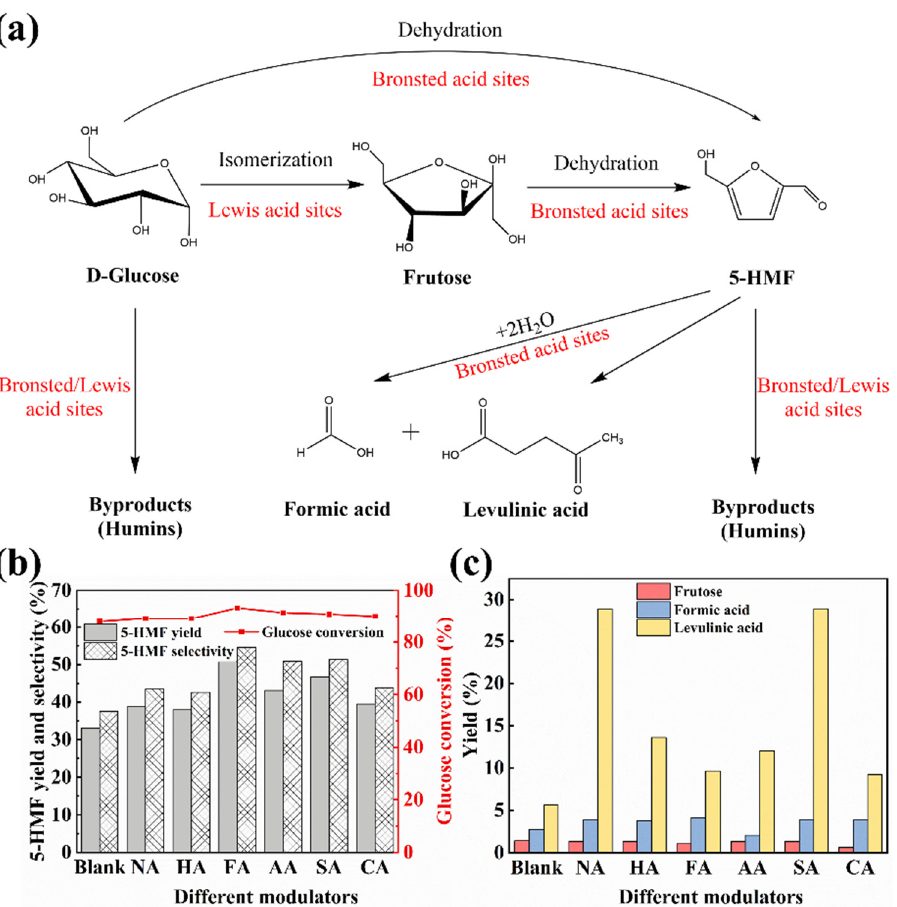
Figure 8. Effects of the blank sample and MIL-101 (Cr, Sn) synthesized with different modulators on glucose conversion to 5-HMF. ( a ) Scheme for synthesizing 5-HMF using glucose as raw material, ( b ) yield, selectivity of 5-HMF, and glucose conversion; ( c ) yields of fructose, formic acid, and le- vulinic acid.